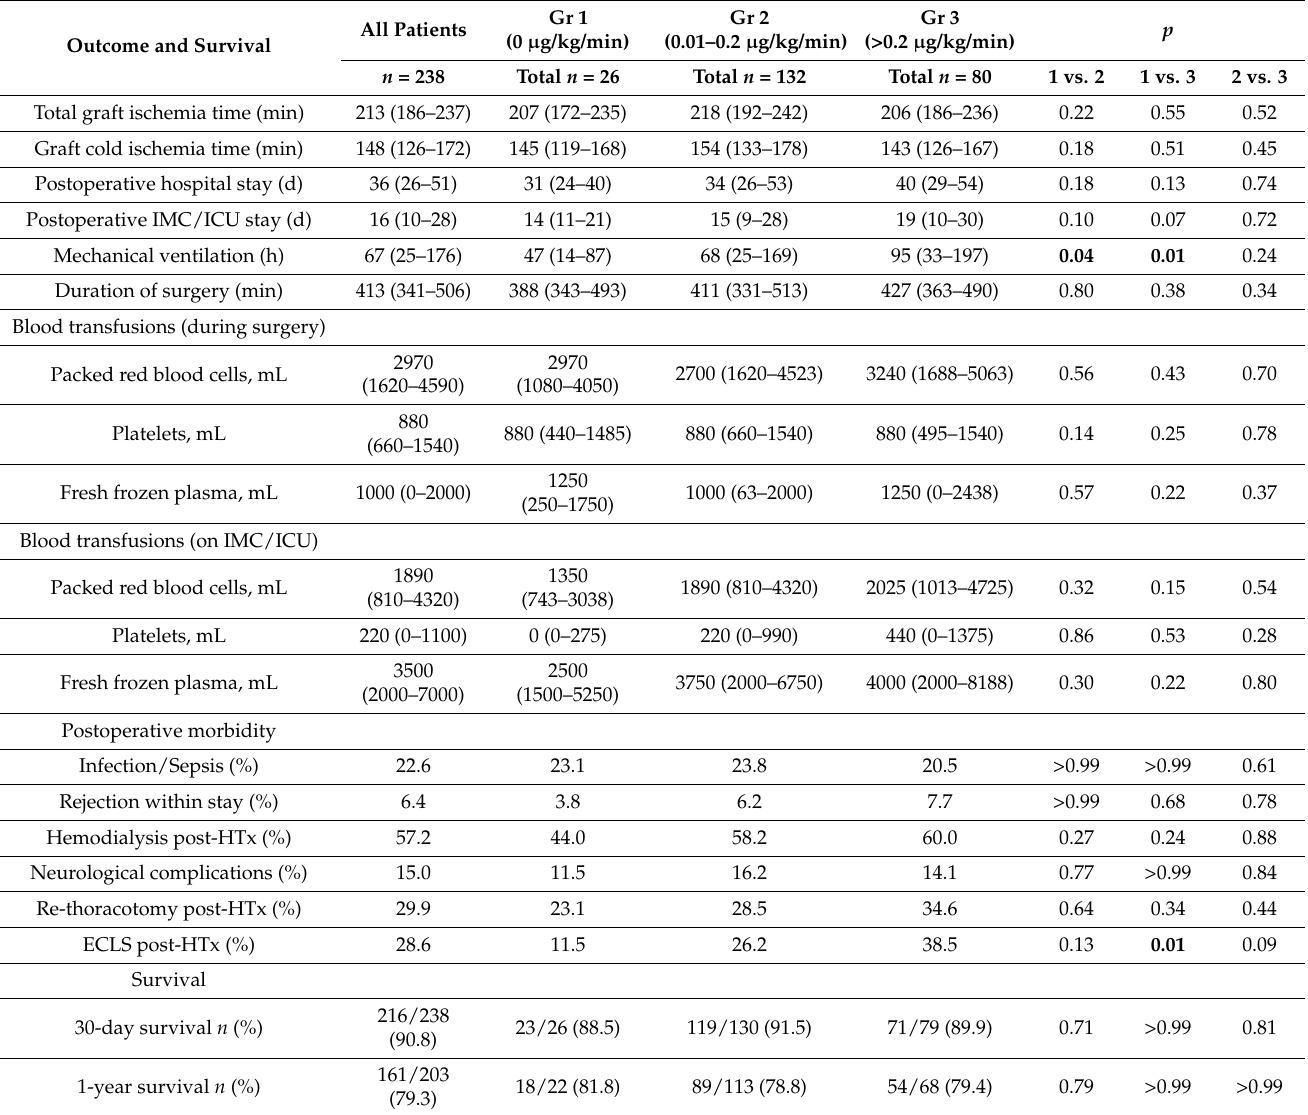
Table 3. Peri- and postoperative parameters and survival, grouped by the donor noradrenaline support prior to heart transplantation: No (0 µ g/kg/min, n = 26), medium (0.01–0.2 µ g/kg/min, n = 132) or high (>0.2 µ g/kg/min, n = 80). Shown are median values with interquartile range (Q1–Q3) for continuous variables or percentages for discrete variables. Significance was calculated using the Pearson chi-square test or, if its conditions of application were not met, the Fisher exact test for qualitative variables and the t -test for quantitative variables. Bold p -values stand for statistical